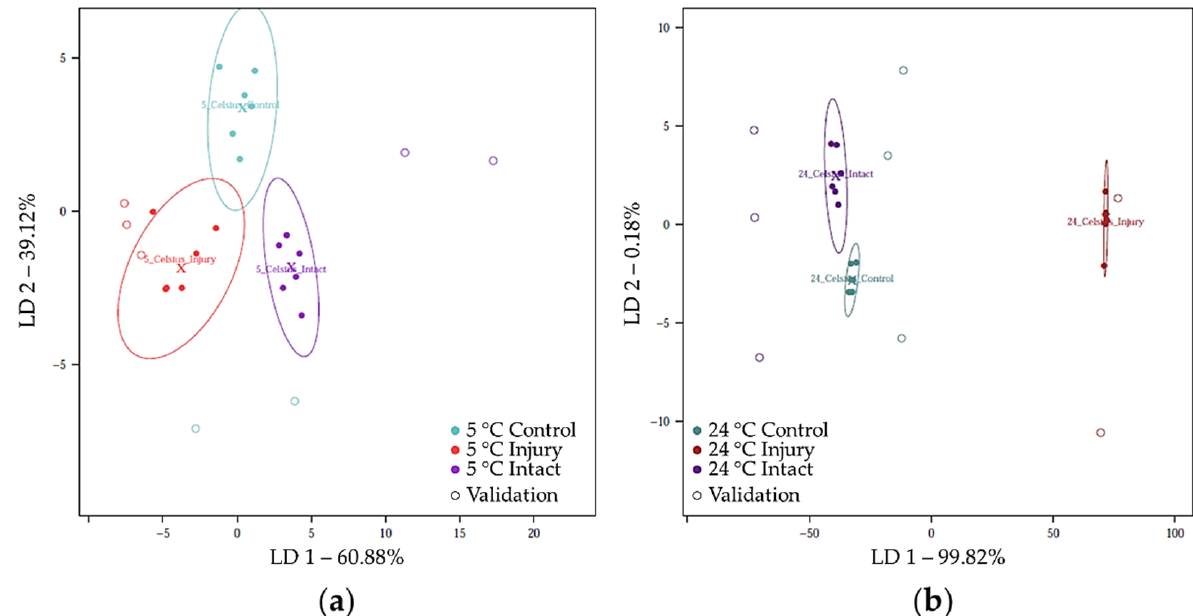
Figure 5. LDA classification model on the e-tongue data of control and infected plum juices with external validation when the inoculation mode was used as class variable: ( a ) LDA of samples stored at 5 °C ( N = 25); and ( b ) LDA of samples stored at 24 °C ( N = 26). Table 7. LDA classification model on the e-tongue data of control and infected plum juices stored at 5 °C with second parallel sample validation when the inoculation mode was used as class variable ( N = 25).